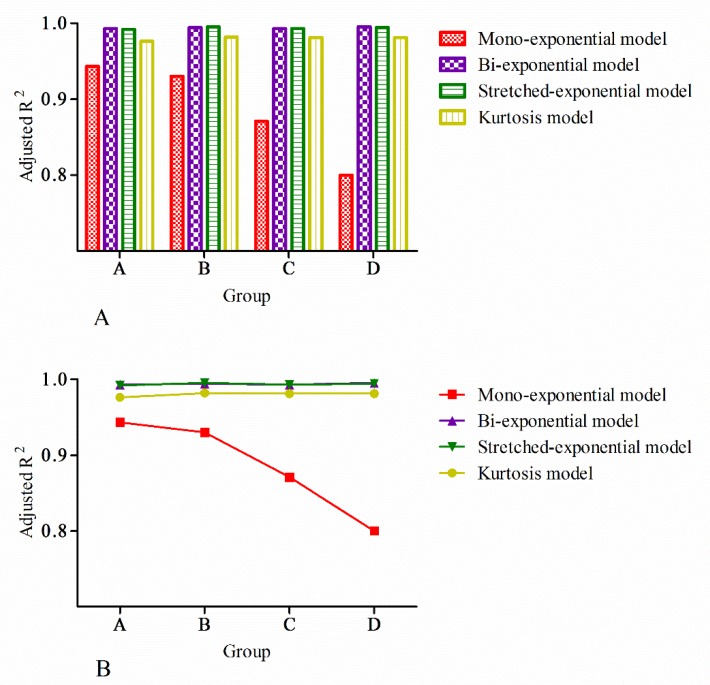
Graph showing variations in the adjusted R2 values of the mono-exponential, bi-exponential, stretched-exponential and kurtosis models with an increase in b-value.The mean value of the adjusted R2 of the mono-exponential model decreased with the increase of b-value, while the mean value of the adjusted R2 of the bi-exponential, stretched-exponential and kurtosis models were stable and excellent with the increase of b-value (It should be noted that, because the adjusted R2 values of the bi-exponential and stretched-exponential models were close, their curves have been superimposed).